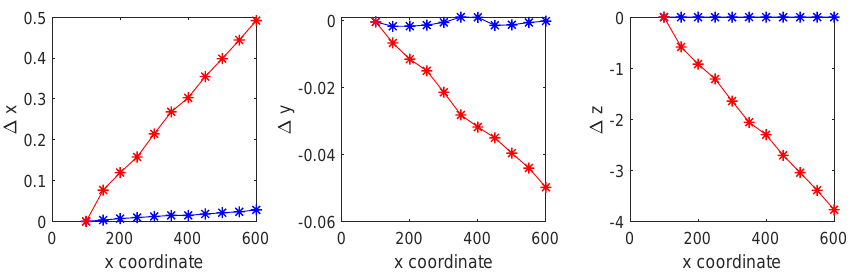
Figure 6. Comparison of ∆ x , ∆ y , ∆ z on the x axis, Trac-Cal results in blue, Case B in red (very inaccurate results of a method based on an ill-conditioned matrix). Units: